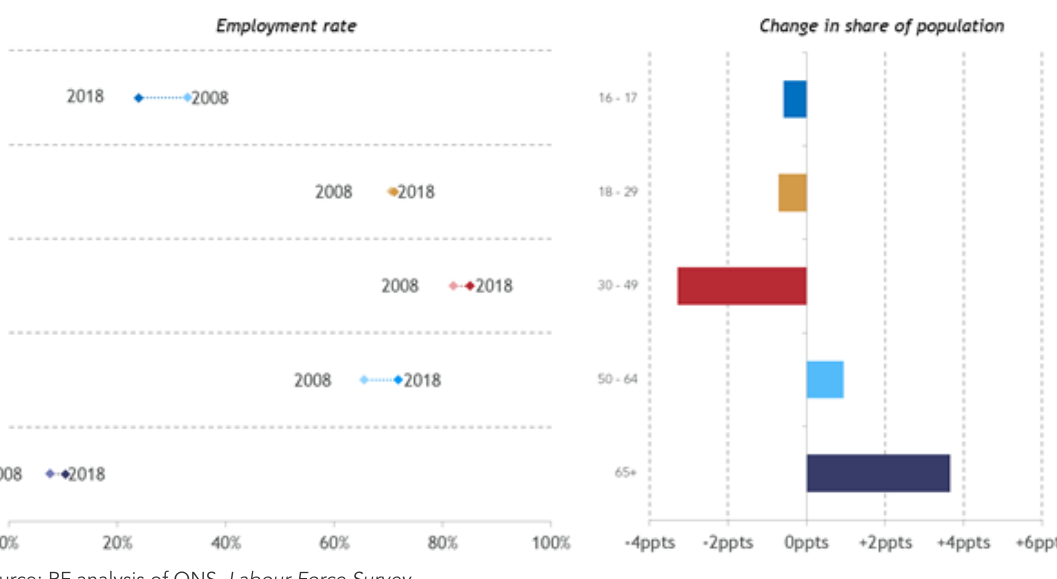
Figure 8: Prime-age workers have shrunk as a share of the population Employment and population changes by country of birth, 16+ year olds: